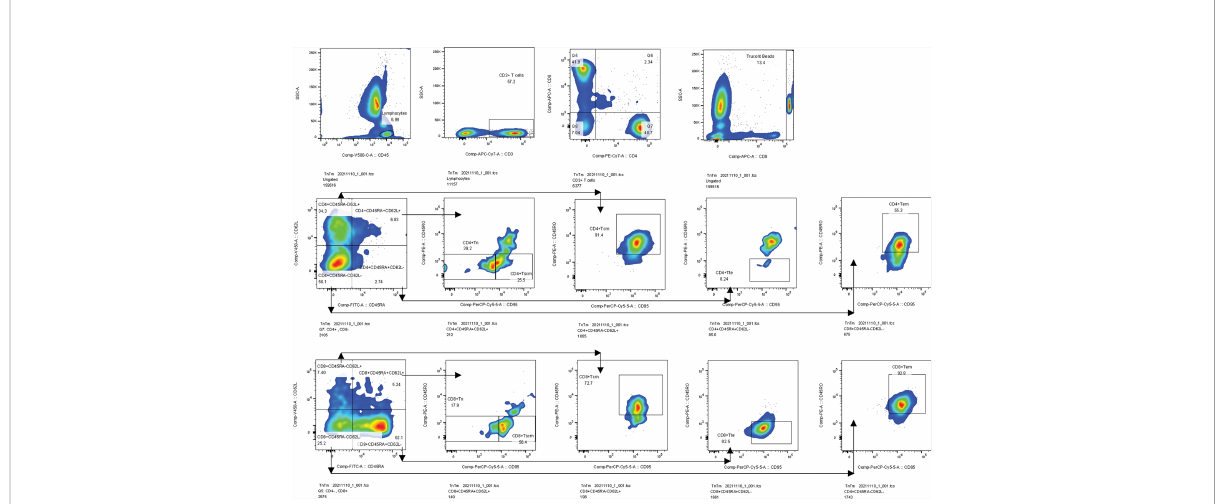
FIGURE 2 Gating strategies. Firstly, we gated lymphocytes identi fi ed by CD45 from a leukocyte, then gated CD3 + T cells from a lymphocyte, and gated CD4 + and CD8 + T cells from CD3 + T cells. Secondly, we gated Trucont Beads. Thirdly, Tn (CD95 - CD45RO - ) and Tscm (CD95 + CD45RO - ) were gated from the CD3 + CD4 + CD45RA + CD62L + T subpopulation. Tcm (CD95 + CD45RO + ) and Tem (CD95 + CD45RO + ) subpopulations were gated from CD3 + CD4 + CD45RA - CD62L + and CD3 + CD4 + CD45RA - CD62L - T subsets, respectively. Tte (CD95 + CD45RO - ) subsets were gated from the CD3 + CD4 + CD45RA + CD62L - T subpopulation. The gating logic for each subset of CD3 + CD8 + T cell is the same as above. Tcm, central memory T cells, Tem, effector memory T cells, Tte, terminal effector T